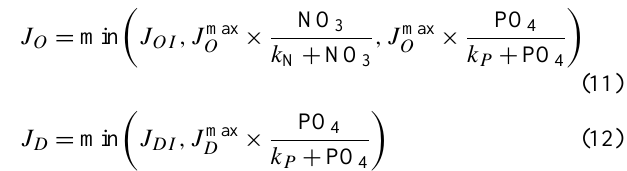
waters ( < 5 µM) where oxygen consumption is